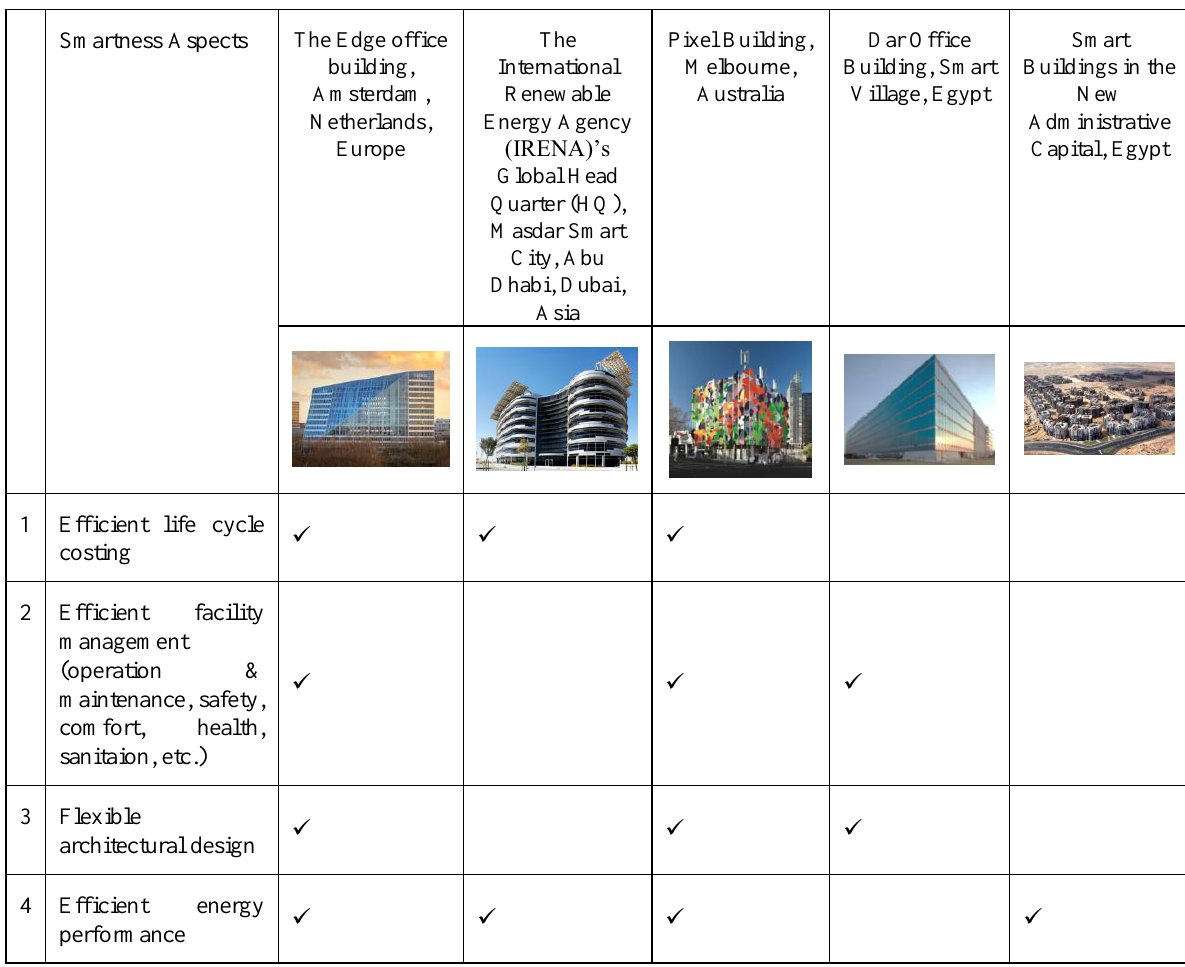
Table 3.Analysis of Case Studies in Egypt and Worldwide; Source: Authors Based on Literature